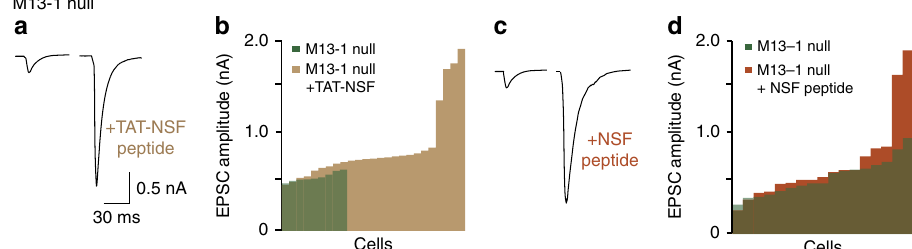
Figure 4 | NSF-specific blockers restore synaptic transmission in munc13-1 null synapses. ( a , b ) Sample traces and histogram of EPSCs in munc13-1 null neurons with and without application of TAT-tagged NSF inhibitor peptide. ( c , d ) Sample traces and histogram of EPSCs in munc13-1 null neurons with or without application of NSF-inhibiting peptide through the pipette. P values are determined by binomial test, *** P o 0.001.